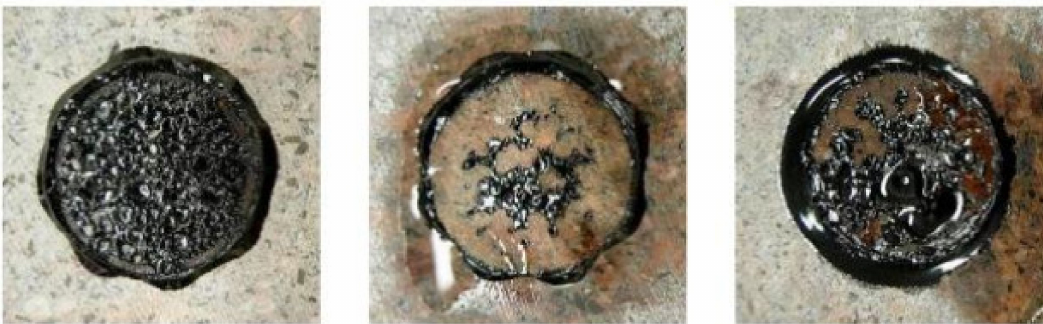
Figure 4. Tested surfaces after BBS Test, cohesive, adhesive and mixed separation (from left to right ) Reprinted with permission from [26] Copyright Taylor & Francis